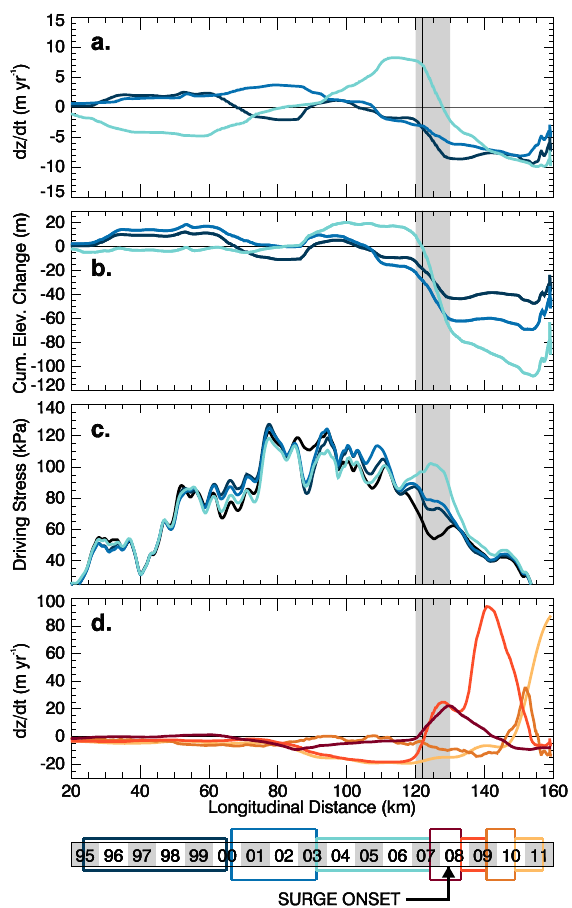
Fig. 5. Results from airborne altimetry on the BGS profile. Flight intervals are indicated on the timeline at the bottom. Blue and red hues correspond to quiescent and surge phases, respectively. Col- ors lighten though time. Grey box and vertical line mark the trigger zone and DBL for the first stage, respectively. (a) Surface elevation change rate during quiescence. (b) Cumulative elevation change from 1995. Colors correspond to the surface profile at the end of each interval. (c) Calculated driving stresses. Black line represents driving stress in 1995; colors correspond to the driving stress at the end of each interval. (d) Surface elevation change rate during the surge phase (same as Fig. 6a).